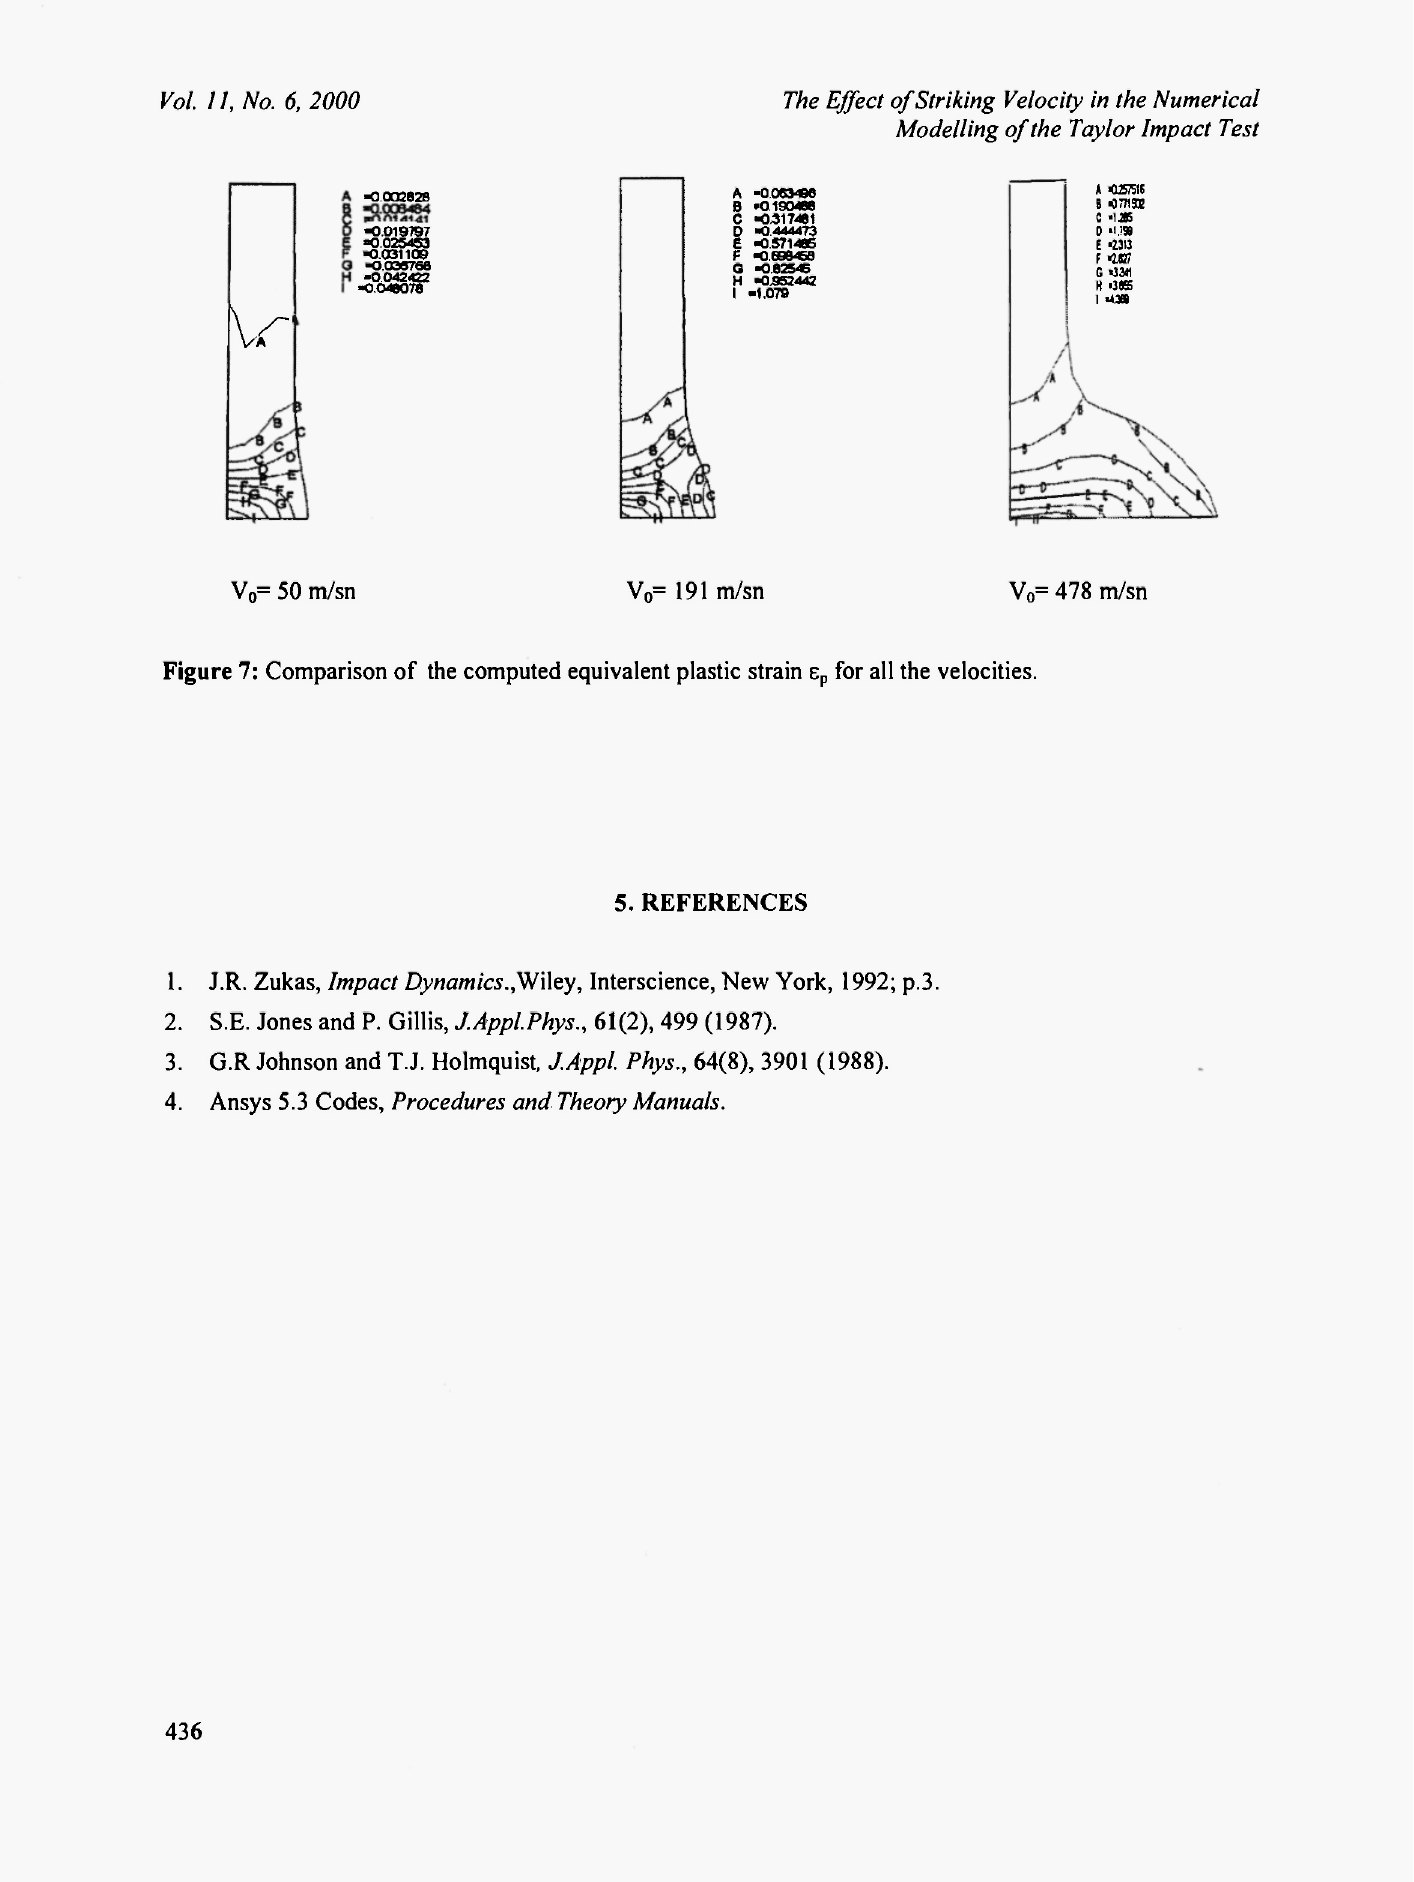
Figure 7: Comparison of the computed equivalent plastic strain ε ρ for all the